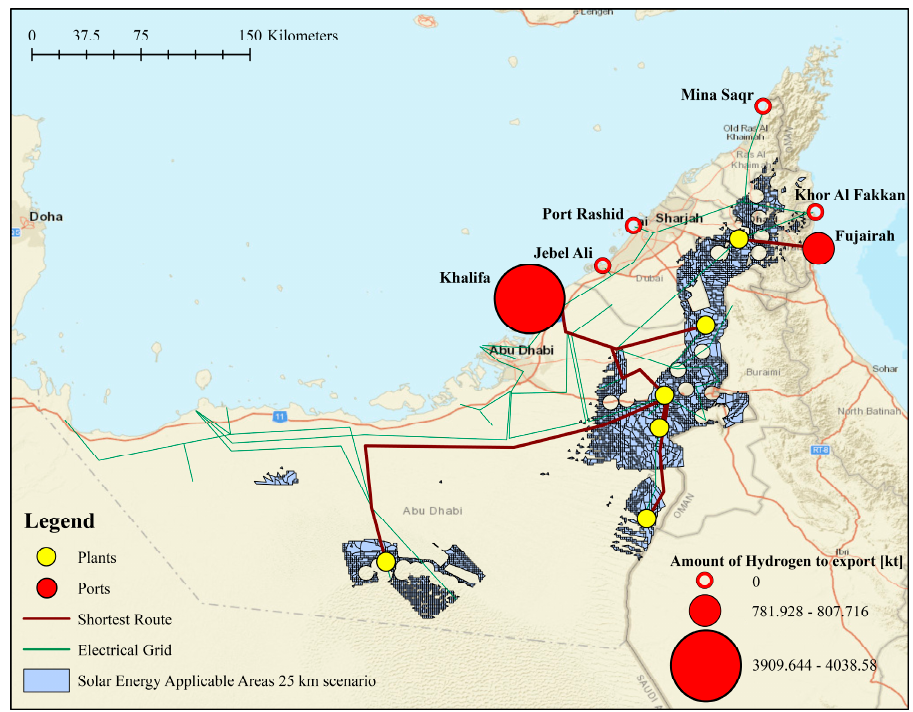
Figure 7. Second pathway GIS analysis results for closest ports and shortest electrical grid routes for electricity transmission from solar plants to port sites.